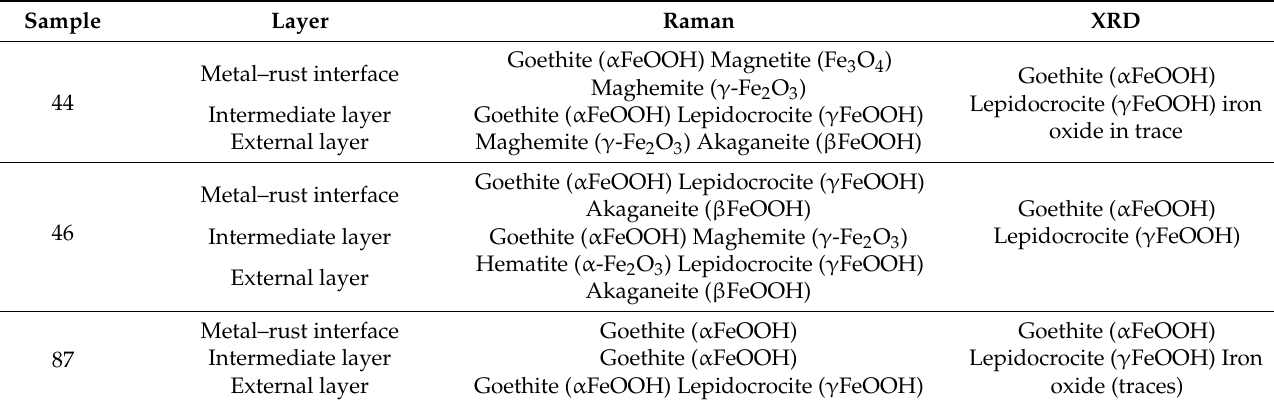
Table 3. Corrosion products detected by Raman spectroscopy and XRD on the San Carlone